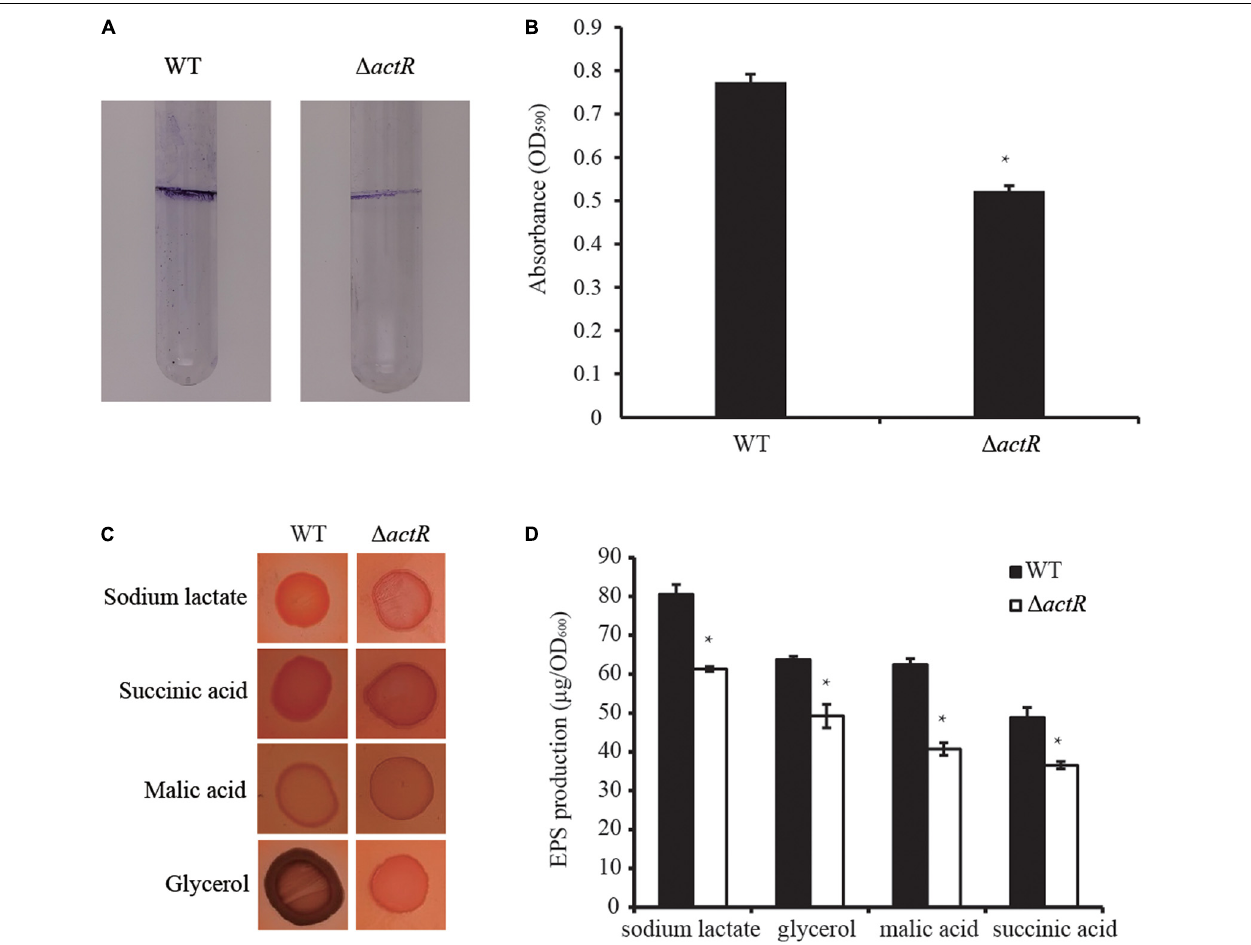
FIGURE 4 | Effects of ActR on the biofilm formation and exopolysaccharide (EPS) production of Azorhizobium caulinodans ORS571. (A) Representative images of biofilms formed by the wild type (WT) and (cid:49) actR. (B) Quantitative analysis of biofilm formation. Bar plot represents the mean and SD of the optical density at 590 nm. (C) Representative images of colony morphologies of the WT strain and (cid:49) actR mutant spotted on the L3 plates with Congo red staining and four different carbon sources (sodium lactate, glycerol, malic acid, and succinic acid). Photographs were taken after 4 days of incubation. (D) Quantitative analysis of the EPS production. Bar plot represents the mean and SD of the optical density at 600 nm of EPS production. Means and SDs of biofilm formation and EPS production were obtained from at least three independent experiments. Student’s t -test; *represents significant difference at p < 0.05.